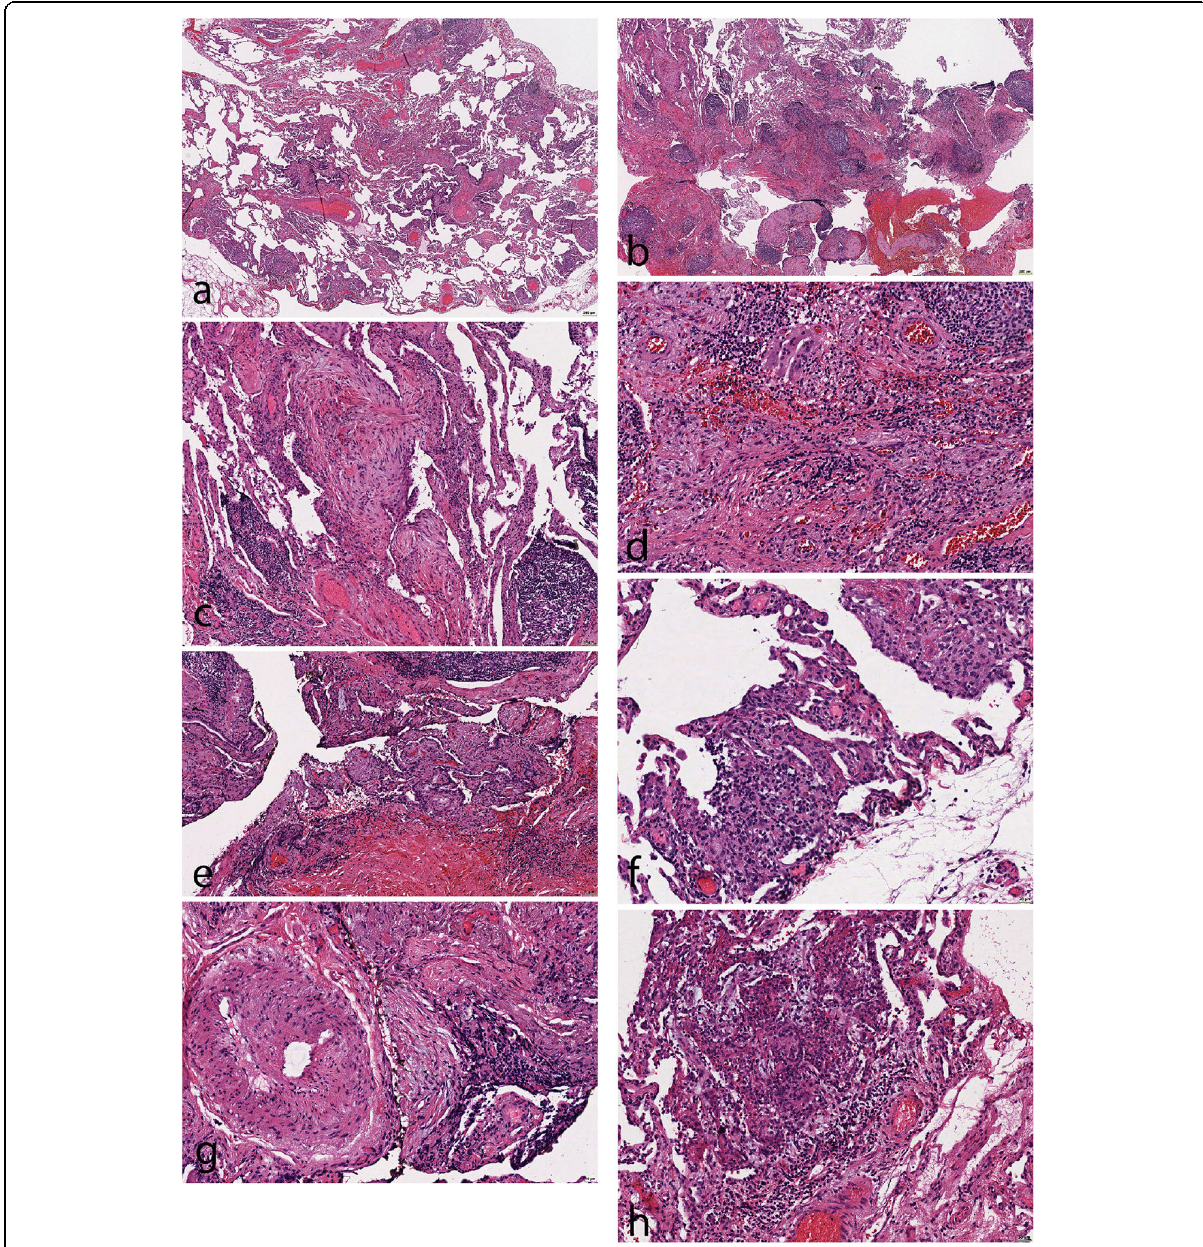
Fig. 24 Chronic hypersensitivity pneumonia, a ) inflammatory infiltrates and cystic remodeling is seen, in b ) BALT hyperplasia and fibrosis, in c ) myofibroblastic foci and lymphocytic infiltrations, in d ) fibrosis, lymphocytes and multinucleated giant cells; e ) shows cystic remodeling and bronchiolar metaplasia, in f and h ) ill formed granulomas and giant cells are seen; in g ) massive sclerosis of a pulmonary artery next to an old myofibroblastic focus are found. H&E, bars 200, 100, 50, and 20 μ m,